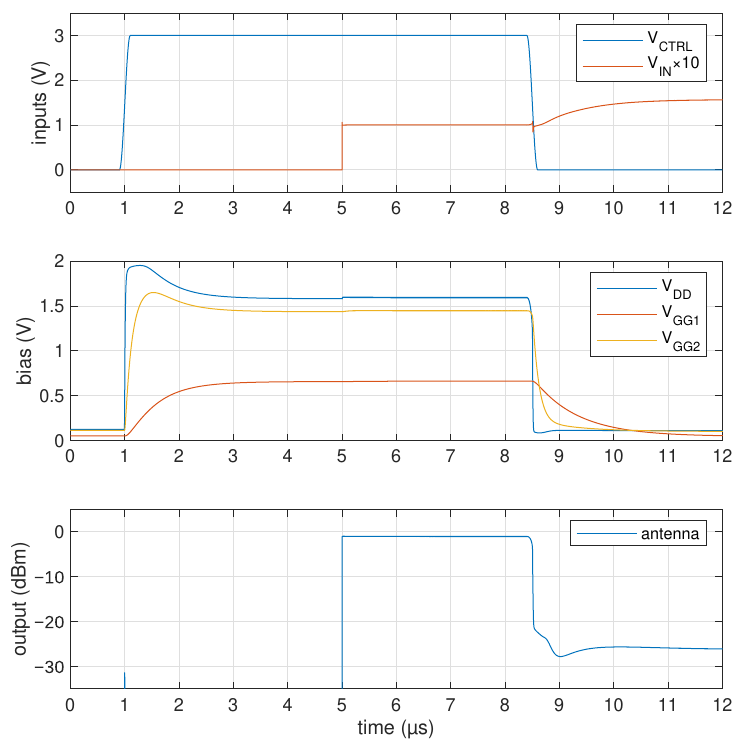
Figure 10. Simulations of the transmit chain transient response. The power switch is enabled at time 1µs for 7.5µs through V CTRL , as shown in the top panel, whereas a − 10dBm (100mV) RF input is applied to the HPA after some time to allow for the power and bias voltages to stabilise (middle panel). The bottom panel shows the resulting power delivered to the antenna, which is − 1.2dBm while the transmitter is